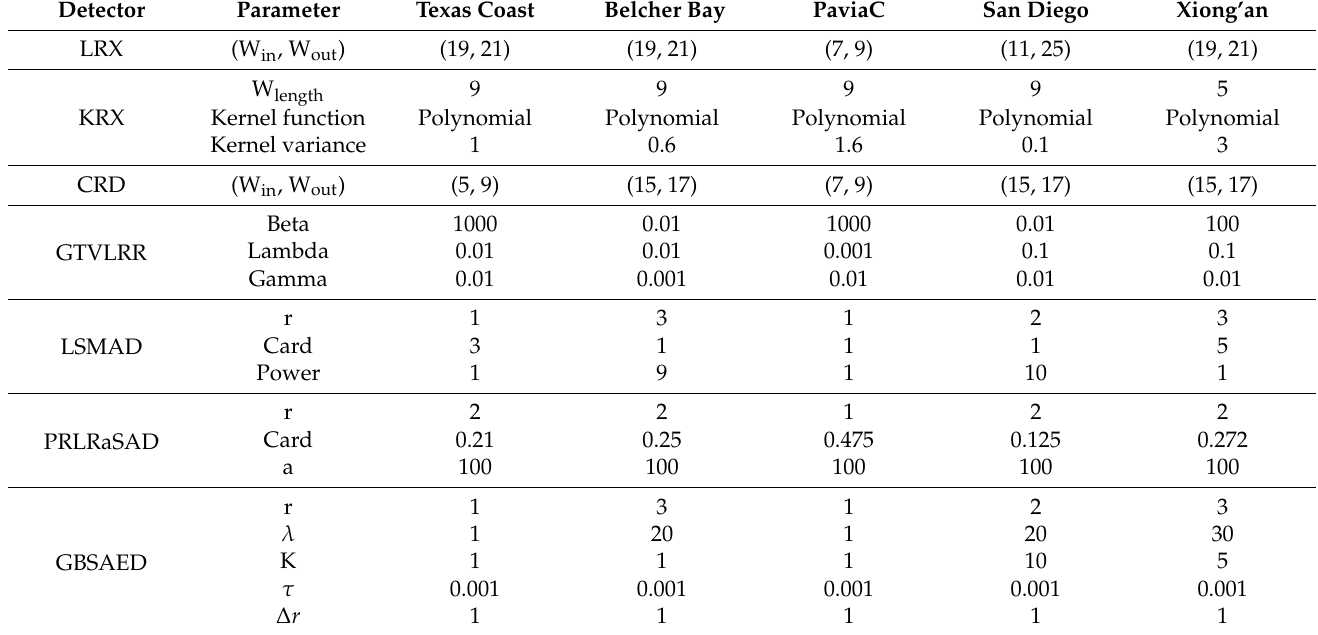
Table 1. Parameter settings of various algorithms.